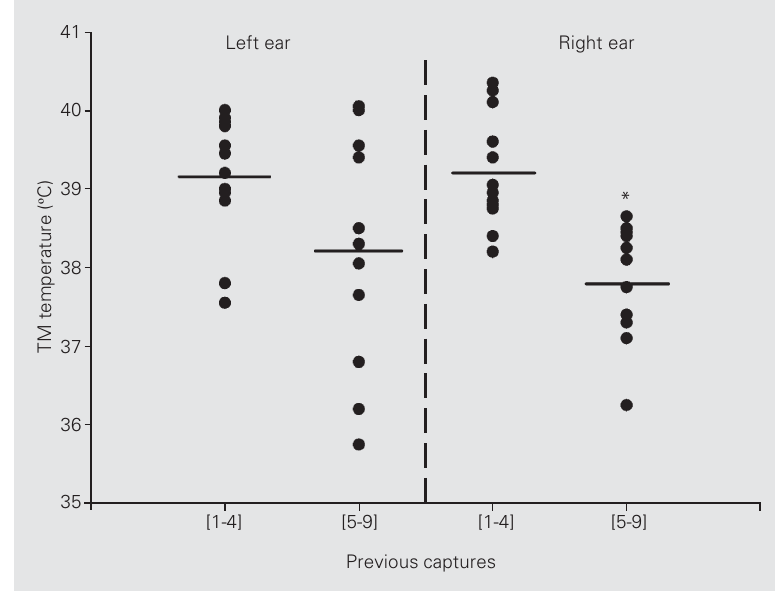
Figure 2. Left and right ear tympanic membrane (TM) temperature in Callithrix penicillata related to the number of previous captures. Each point represents one marmoset (N = 24). The horizontal bars indicate the mean temperature. *P<0.001 compared to right ear (1-4 previous captures) (Mann-Whitney